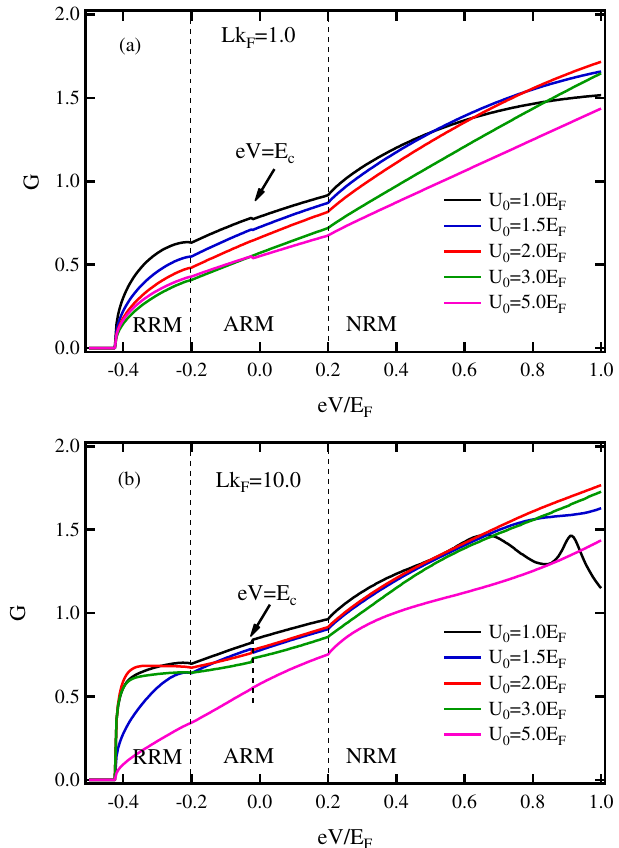
Figure 3. (Color online) Conductance spectra in the applied voltage for different values of the barrier potential in case of 0 < M 2 < E α . ( a ) Lk F = 1.0, ( b ) Lk F = 10.0. Here, the parameters were set as m R = m FM , M 2 = 0.2 E F and E α = 0.4 E F